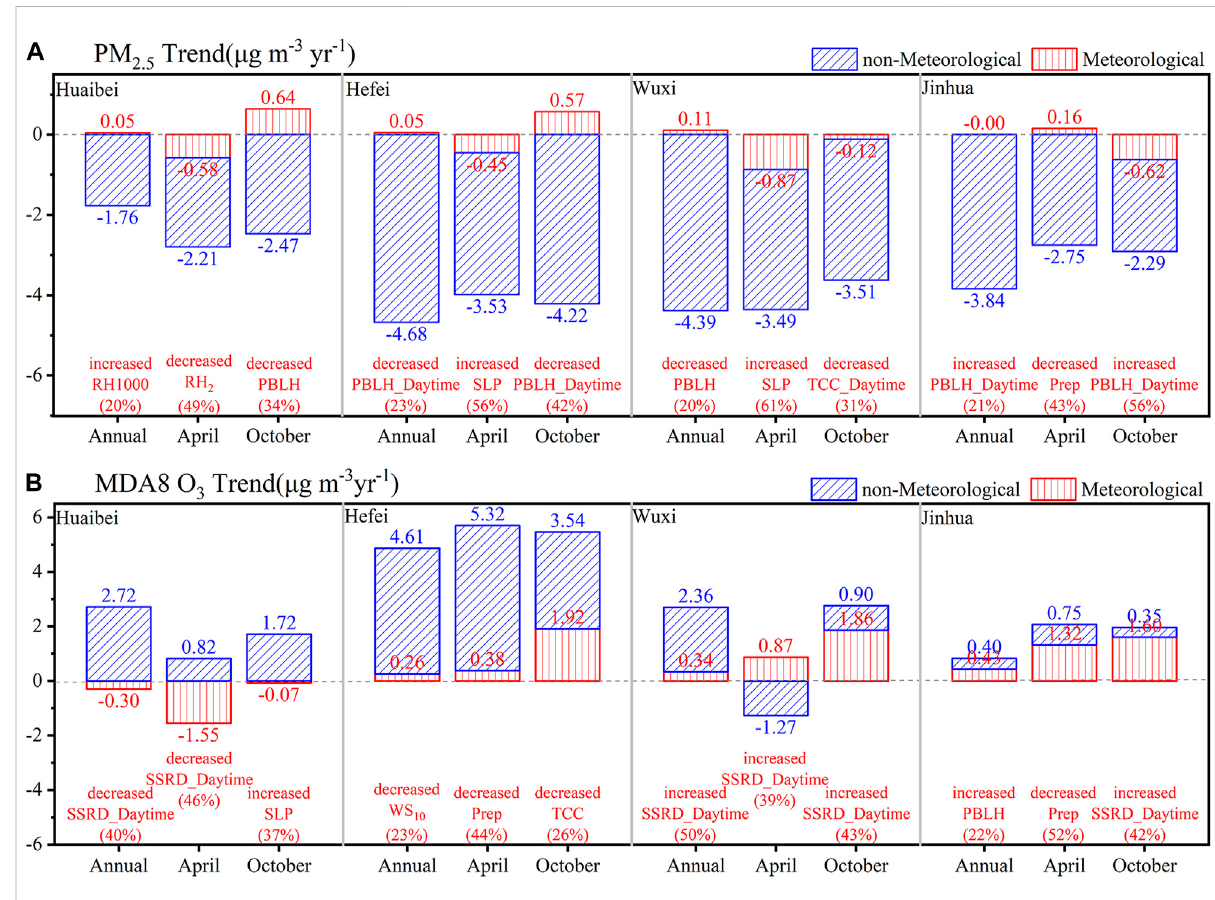
FIGURE 10 Contributions of meteorological-driven and non-meteorological factors to trends of annual, April, and October (A) PM 2.5 and (B) MDA8 O 3 in Huaibei, Hefei, Wuxi, and Jinhua cities from 2015 through 2021. The contribution of the most in fl uential meteorological factors (percentage) to the total meteorological-driven trend is marked in